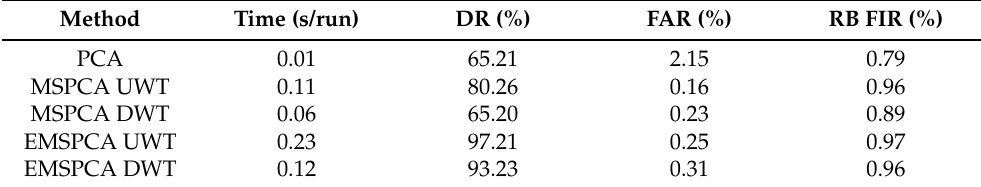
Table 1. A Comparison of The Average Computational Time for Fault Detection and Isolation.